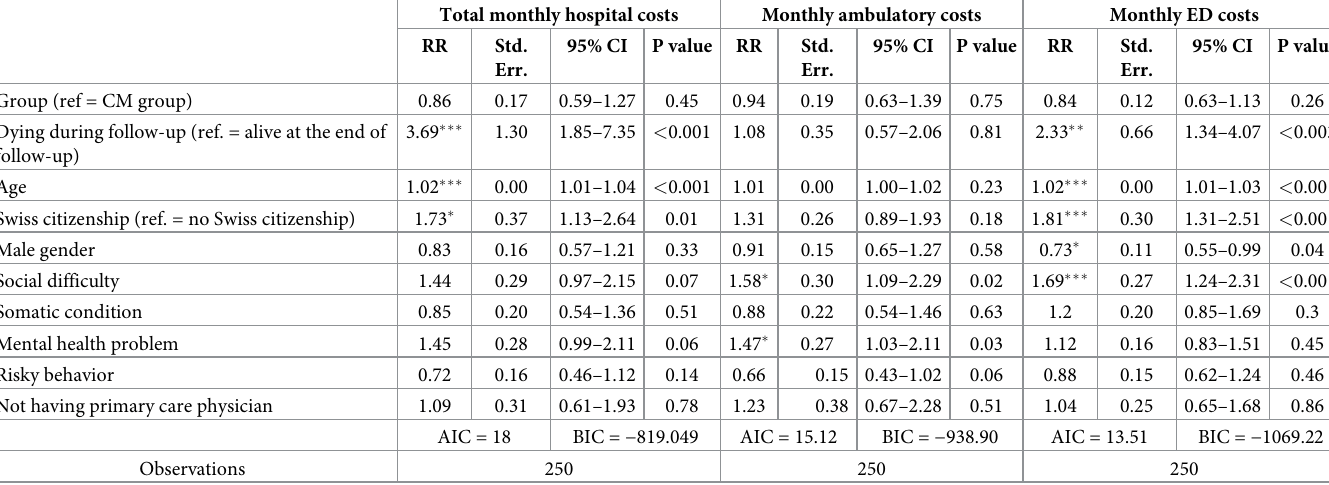
Table 3. Results of gamma-log GLMs for cost outcomes evaluated from the hospital perspective: Total, ambulatory, and ED